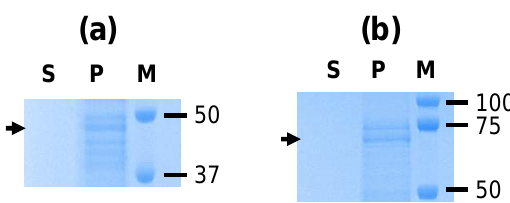
Figure 2. Sodium dodecyl sulfate polyacrylamide gel electrophoresis (SDS-PAGE) analyses